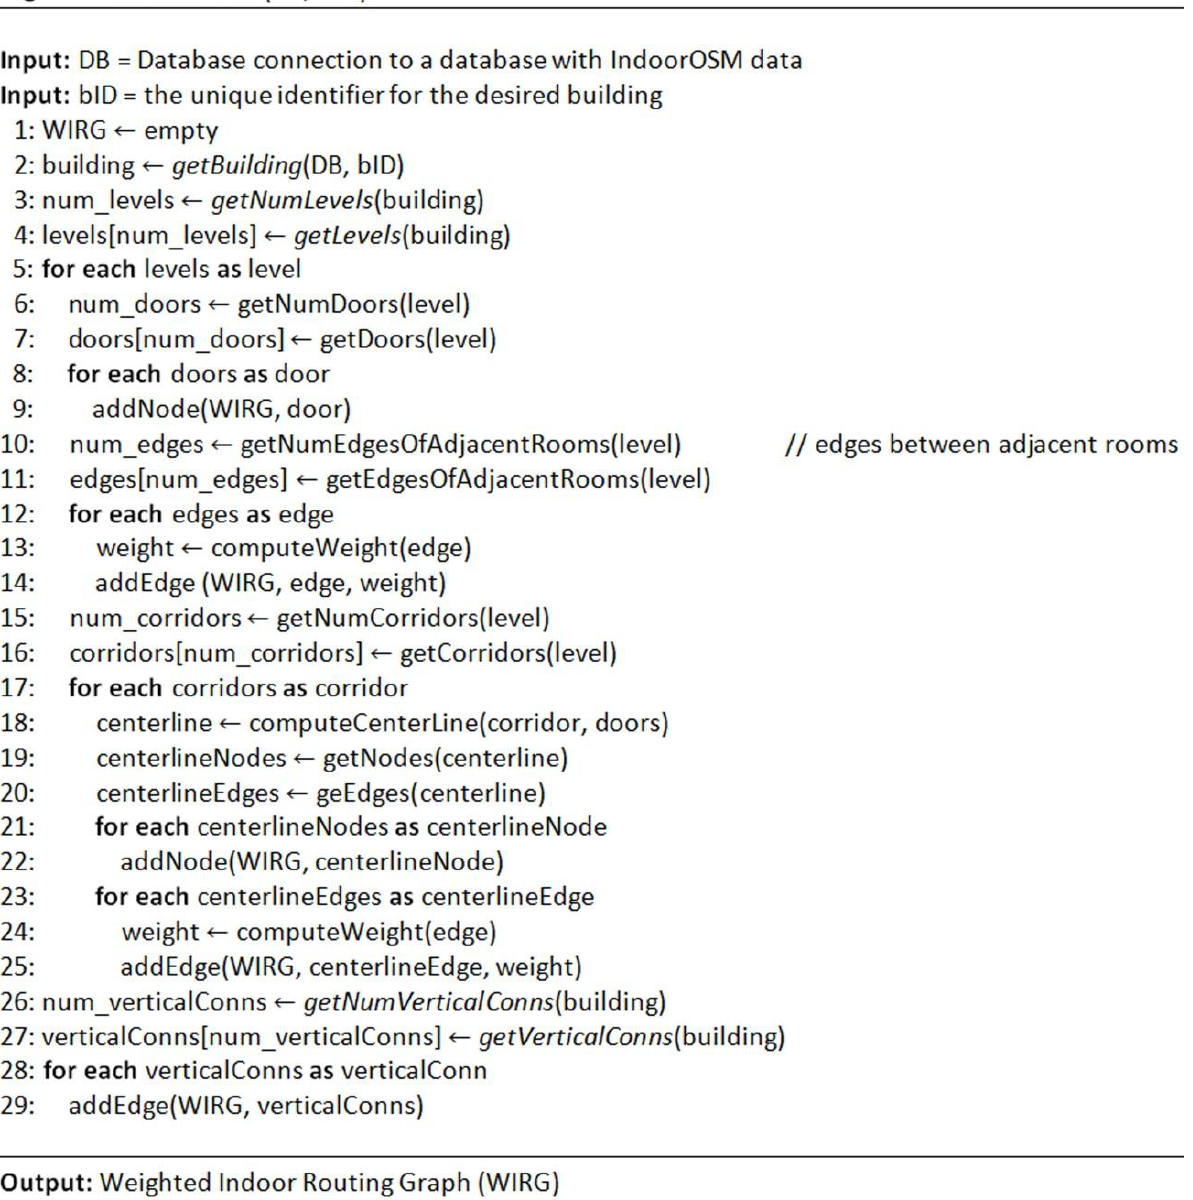
Figure 3. Pseudo-code algorithm for the automated generation of a WIRG from IndoorOSM